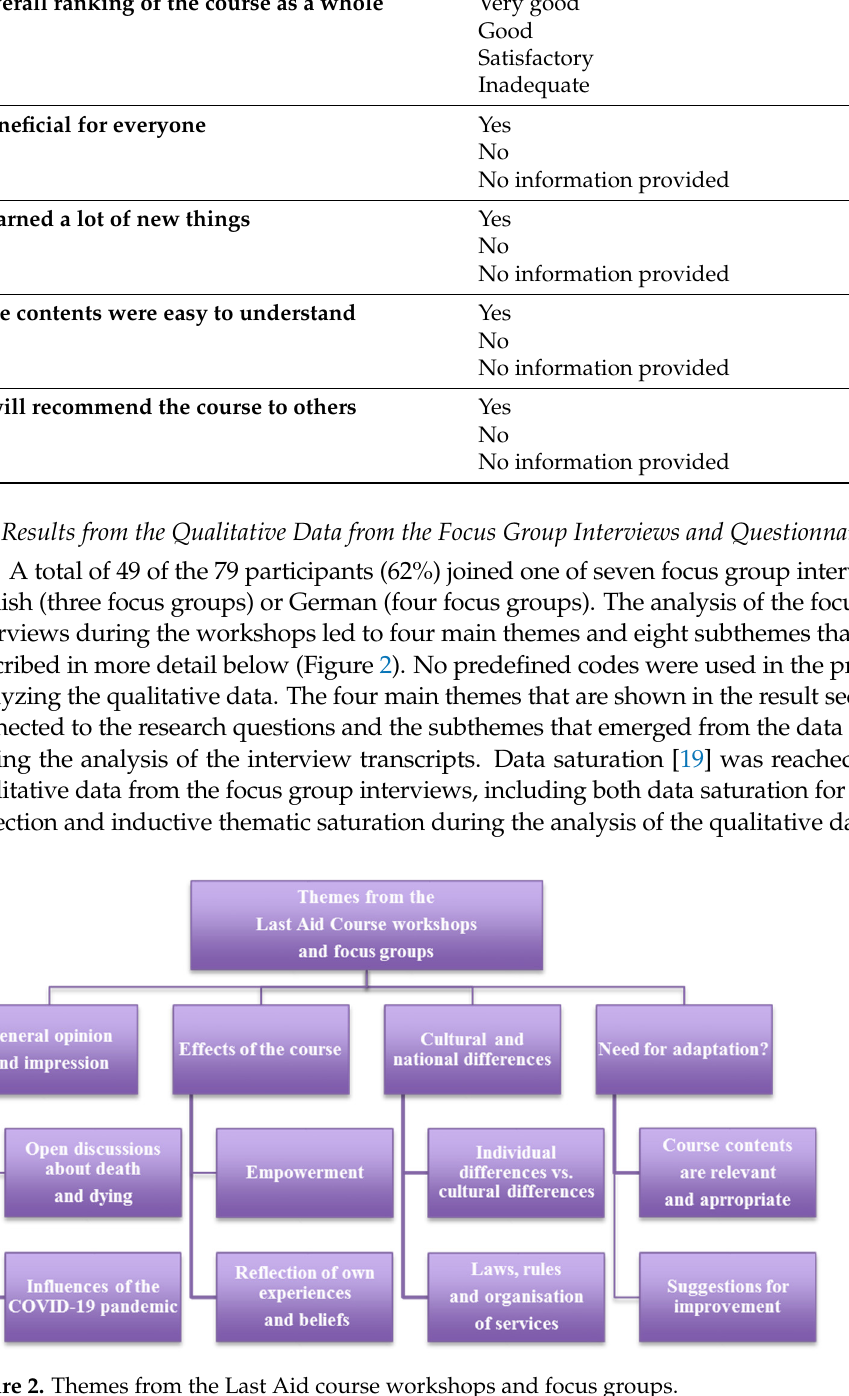
Figure 2. Themes from the Last Aid course workshops and focus groups